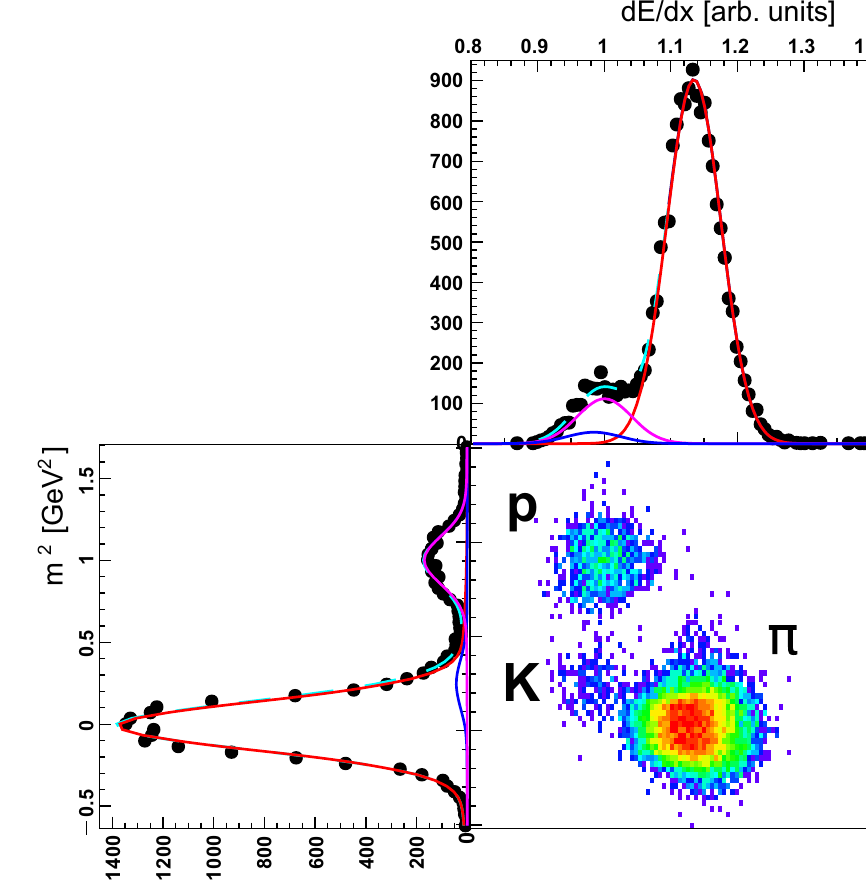
Fig. 9 Example of the tof -d E / d x fit (Eq. (4)) obtained in a single phase-space bin (3 < p < 4 GeV / c and 0.2 lab < p < 0.3 GeV / c ) for T positively charged particles in p + p interactions at 158 GeV / c . Lines show projections of obtained fits for pions (red), kaons (blue) and protons